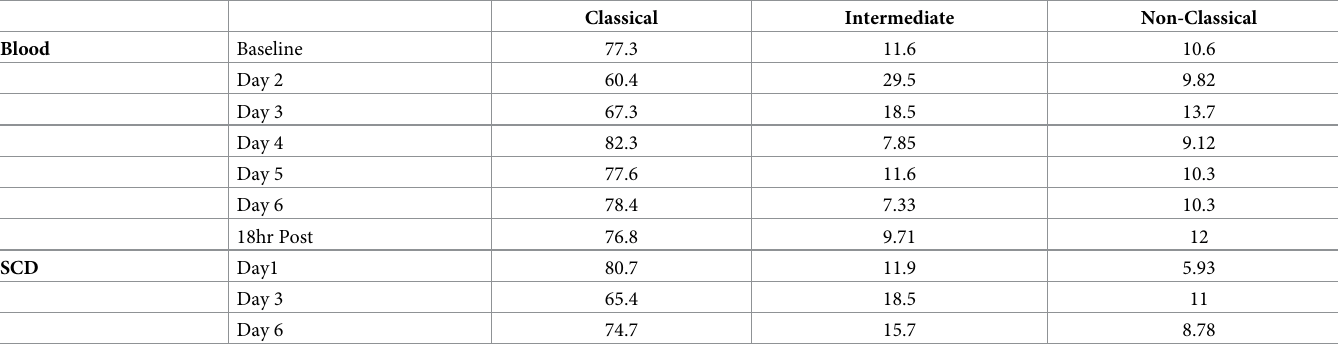
Table 5. Monocyte subsets in enrolled